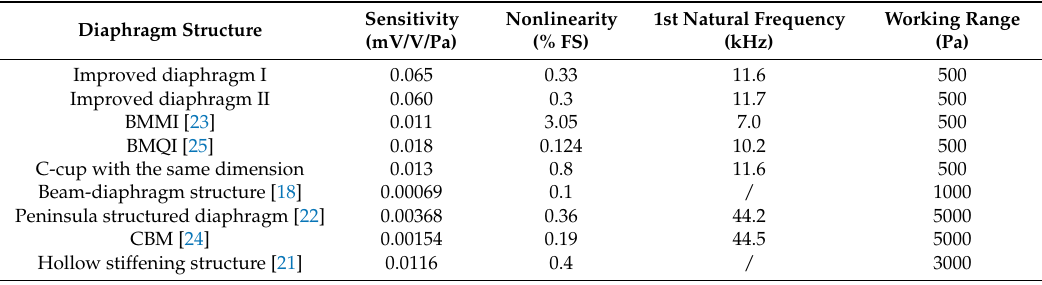
Table 4. The sensor performance comparisons among the proposed bossed diaphragms and previously researched sensing